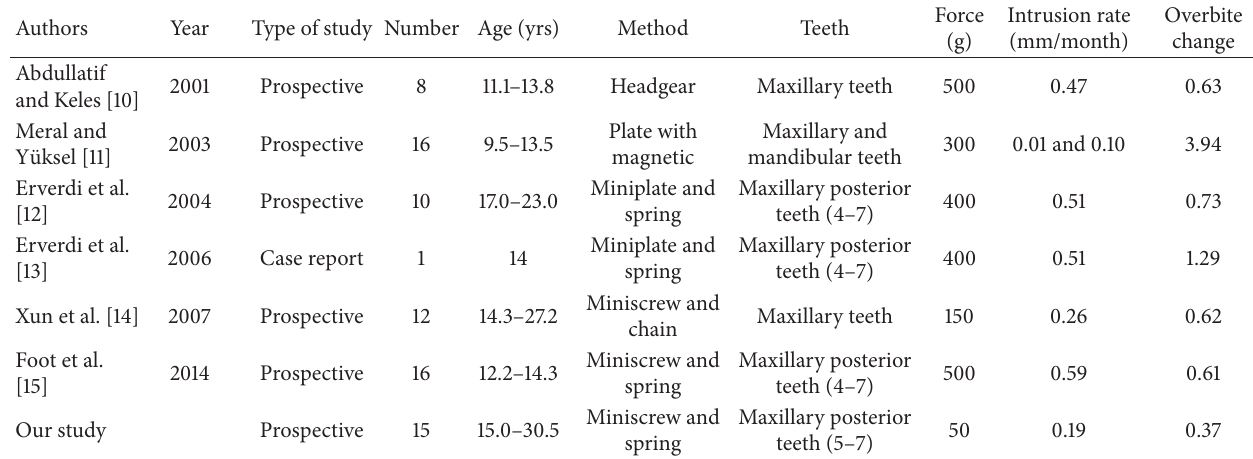
Figure 7: A boxplot graph of the chondroitin sulphate (CS) levels around the maxillary second premolar (a), first molar (b), and second molar (c) during the unloaded period (week 0) and the loaded periods (week 1 to week 8). The small circles represent outlier values, and small asterisks represent extreme values. Table 1: Summary of articles on segmental maxillary posterior tooth